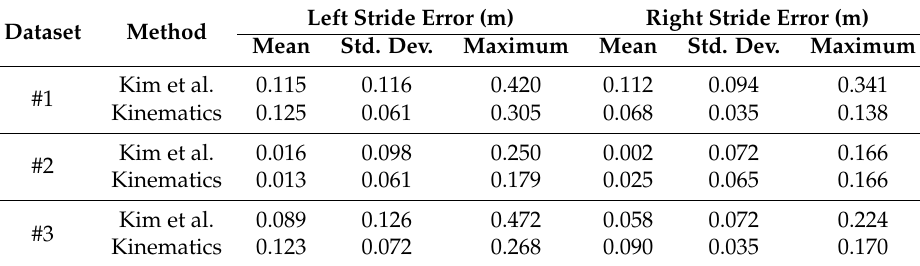
Figure 16. Stride length error distributions between different methods. Table 5. Stride length error